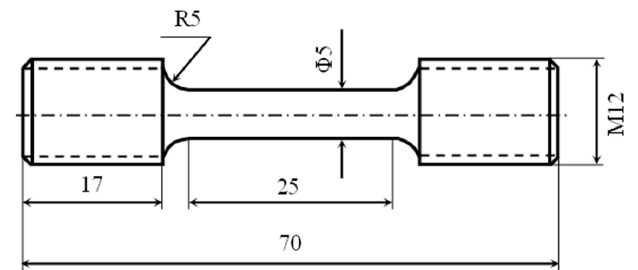
Figure 1. Tensile specimen and size.